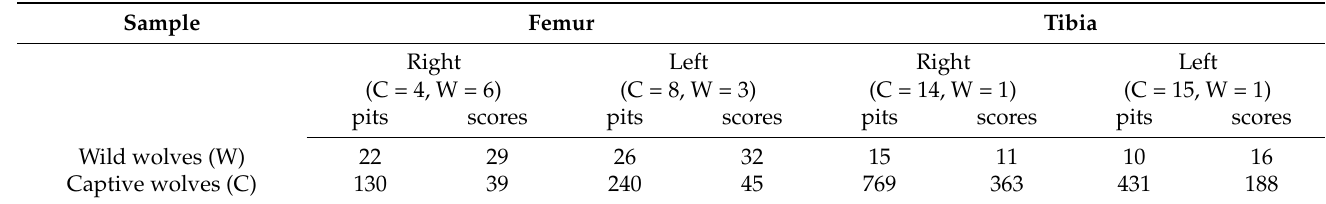
Figure 1. Tooth marks, including pits (black) and scores (red), digitized on the femur and tibia 3D models available in Ikhnos for middle-sized carcasses according to their location and orientation in the case of scores. Table 2. Tooth marks identified in the El Hosquillo, Pico V í zcares and Villardeciervos